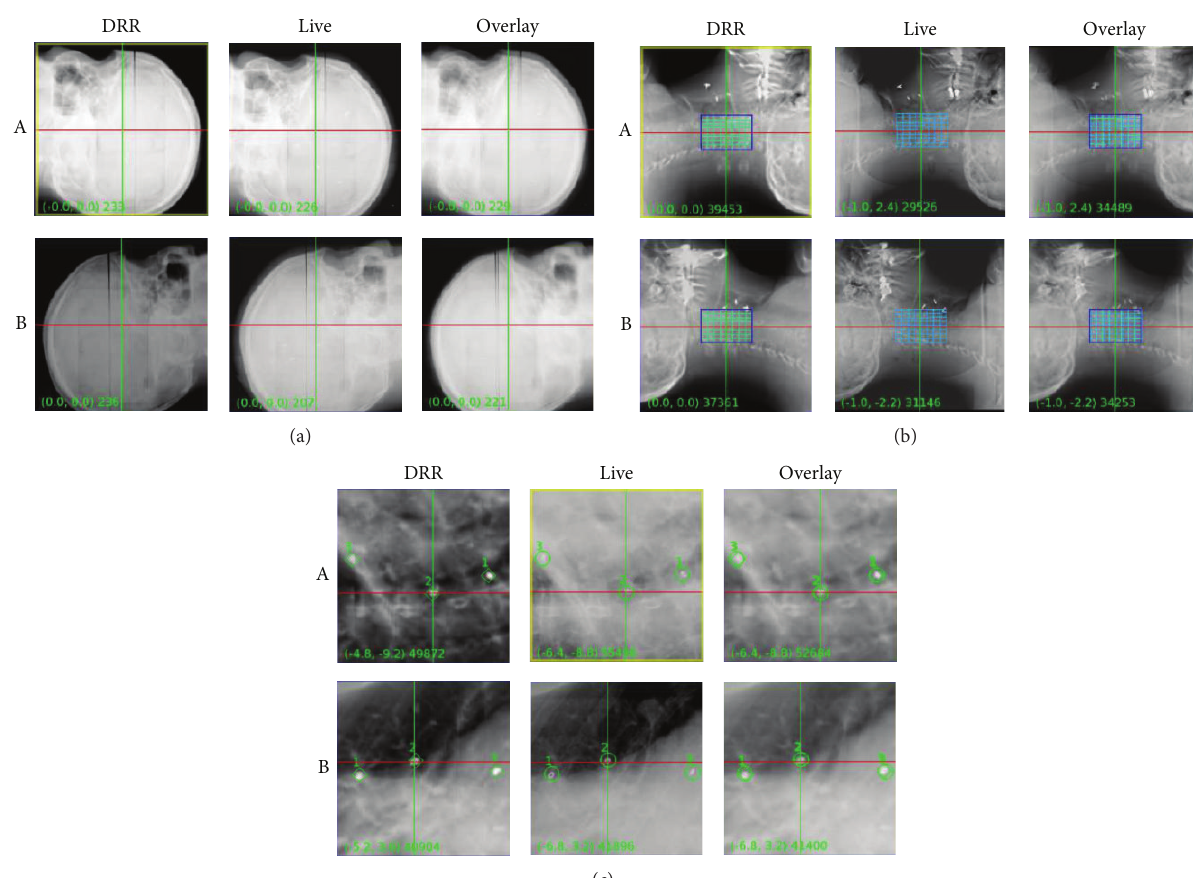
Figure 3: CyberKnife console showing the tumor tracking options in a case of head and neck malignancy. (a) 6D skull for skull base lesions. (b) Spine tracking for paravertebral tumors. (c) Fiducial tracking for all other lesions whose motion is independent of skull or spine position, such as base of tongue or neck